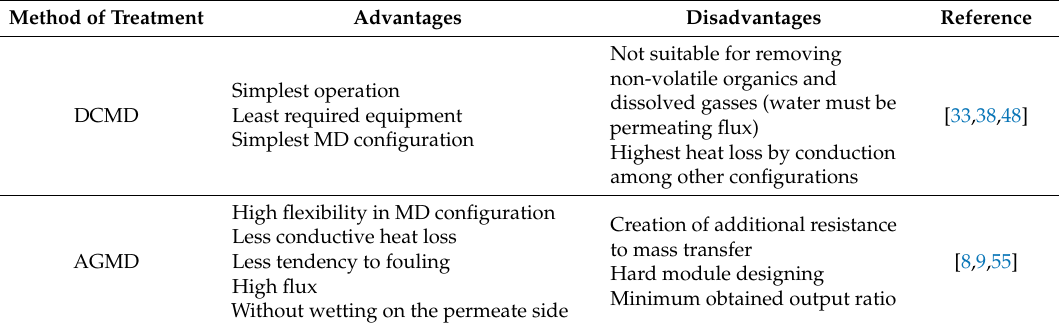
Table 4. The merits and demerits of conventional MD